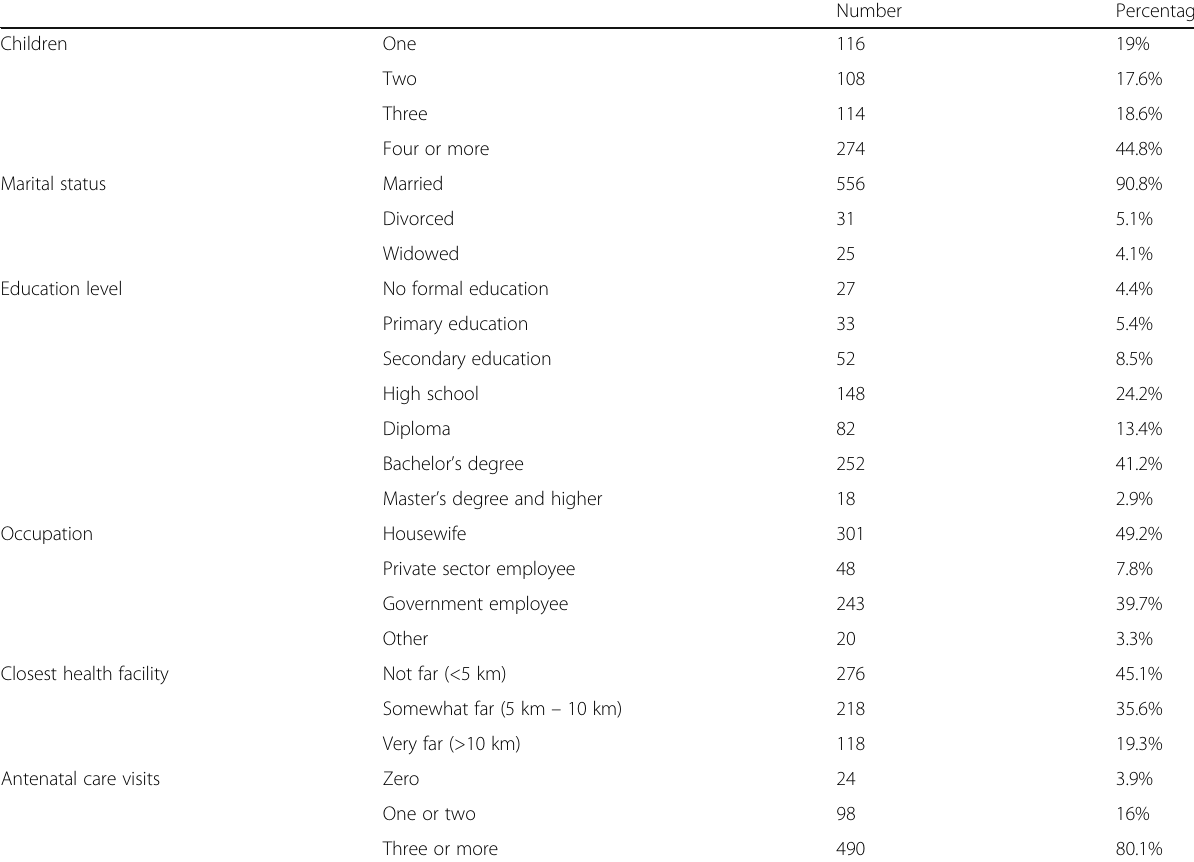
Table 1 Sociodemographic characteristics of the study participants